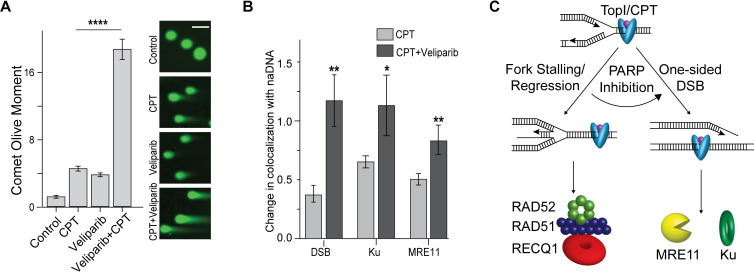
PARP inhibition converts RAD52/RAD51 protected RFs into seDSBs.(A) Comet assays of cells damaged with CPT, Veliparib or both demonstrating synergistic DSB induction upon TopI-induced RF stress combined with PARP inhibition. Representative cells shown. (B) Quantification of DSB (TUNEL), Ku and MRE11 association with naDNA upon PARP inhibition using a combined Veliparib/CPT treatment. (C) A model of the two predominant stress pathways induced by TopsIcc: RF stalling/regression, which is protected and repaired quickly and colocalizes with RAD51 and RAD52, and osDSBs, which colocalize with Ku and MRE11 and are repaired via HR. Representative comet assayed cells shown, scale bars represent 15 μm. Complete N values available in S1 and S2 Tables, number of replicates >3, number of cells imaged typically 20–60, number of individual foci manually scored typically 50–70. All graphs show mean ± s.e.m. Student’s t-test results shown for comparison with control levels in (A) and with CPT-only (B): ns depicts p>0.05, * depicts p<0.05, ** depicts p<0.01, **** depicts p<0.0001.